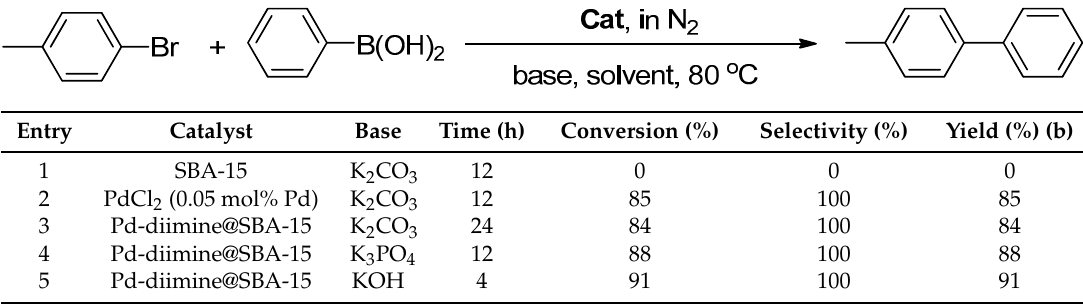
Table 2. Effect of base on the Suzuki coupling reaction of para-bromotoluene with phenylboronic acid over the Pd-diimine@SBA-15 catalyst at 80 ◦ C (a).